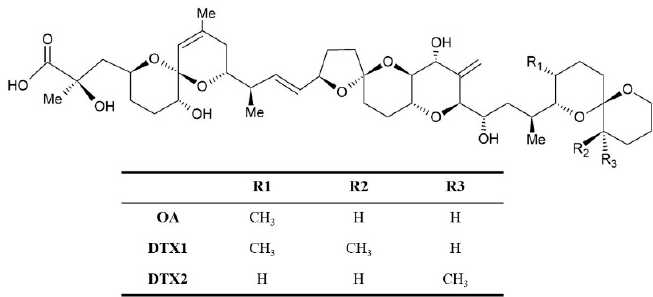
Figure 1. Chemical structure of OA, DTX1, and DTX2.